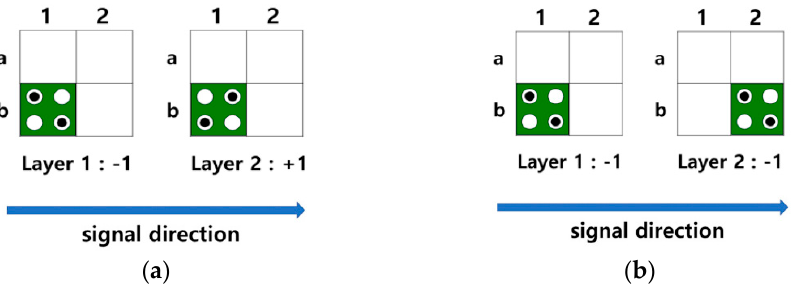
Figure 3. Signal transmission in multi-layer: ( a ) Grid expression of vertical transmission; ( b ) Grid expression of diagonal transmission.